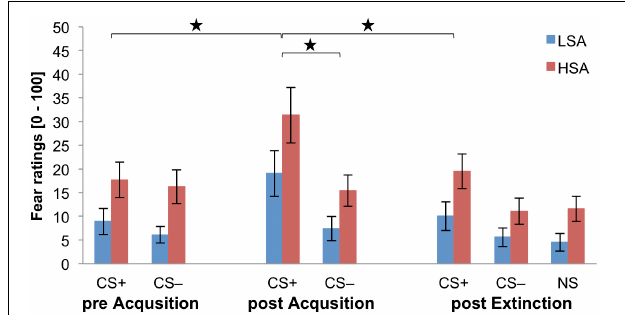
FIGURE 3 | Fear ratings ( n = 53) for CS+, CS − , and NS in the three rating phases for low (LSA) and high socially anxious (HSA) participants. CS+ = agent paired with aversive unconditioned stimulus (US); CS – = agent without aversive US; NS = agent without aversive US and appearing only in the extinction phase; pre Acquisition = before acquisition phase; post Acquisition = after acquisition phase; post Extinction = after extinction phase. Mean fear ratings (0 = very low fear to 100 = very high fear) were given. Significant differences are indicated with an asterisk. Standard errors are presented by error bars.